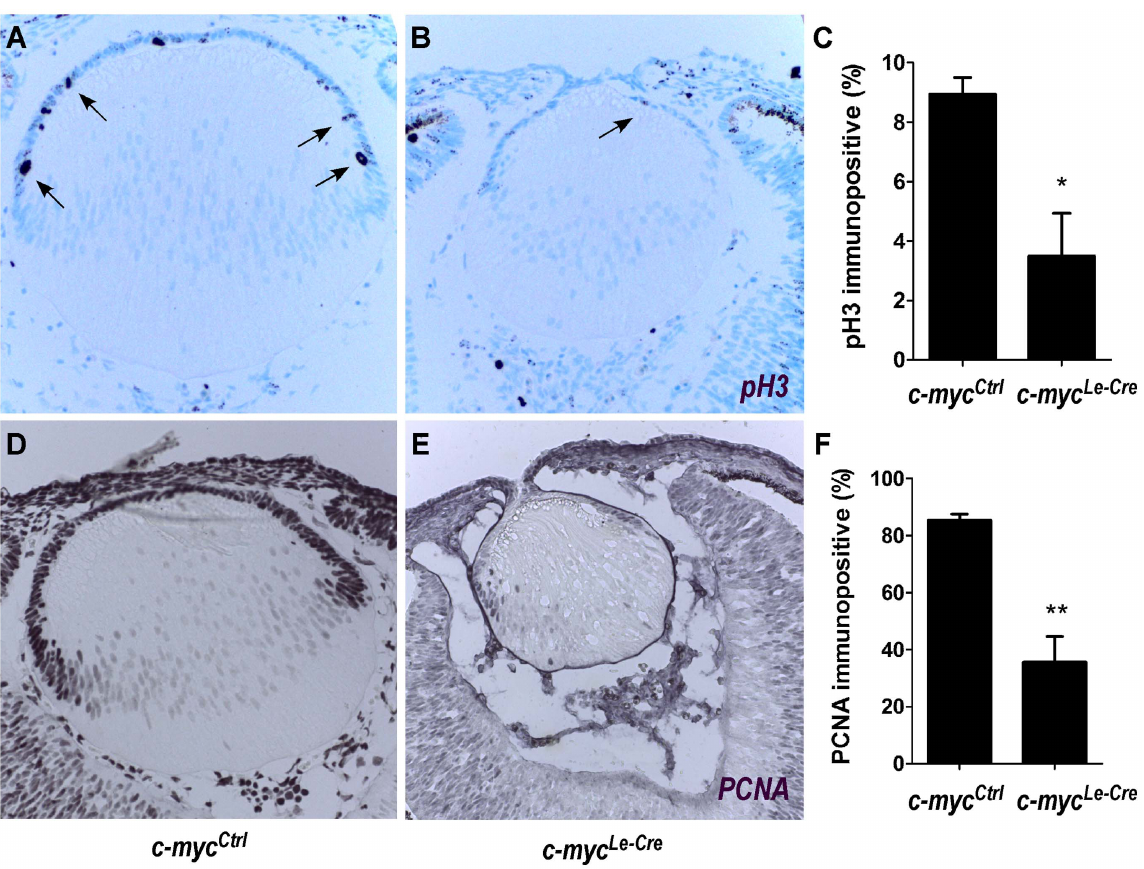
Figure 5. c-myc regulates lens epithelial cells proliferation. Immunohistochemistry for pH3 ( A–B ) and PCNA ( D–E ) were performed in control ( c-myc Ctrl ) and c-myc-deficient ( c-myc Le-Cre ) lens sections at E13.5 followed by methylgreen nuclear counterstaining. Proportions of pH3 immunopositive cells (arrows) ( C ) and PCNA immunopositive cells ( F ) were scored within lens epithelial cells ( c-myc Le-Cre ; n=5; c-myc Ctrl ; n=4). Inactivation of c-myc reduced the proportion of proliferating cells within lens tissue in vivo . Error bars indicate SEM. A t-test resulted in * p , 0, 05; ** p , 0, 01.